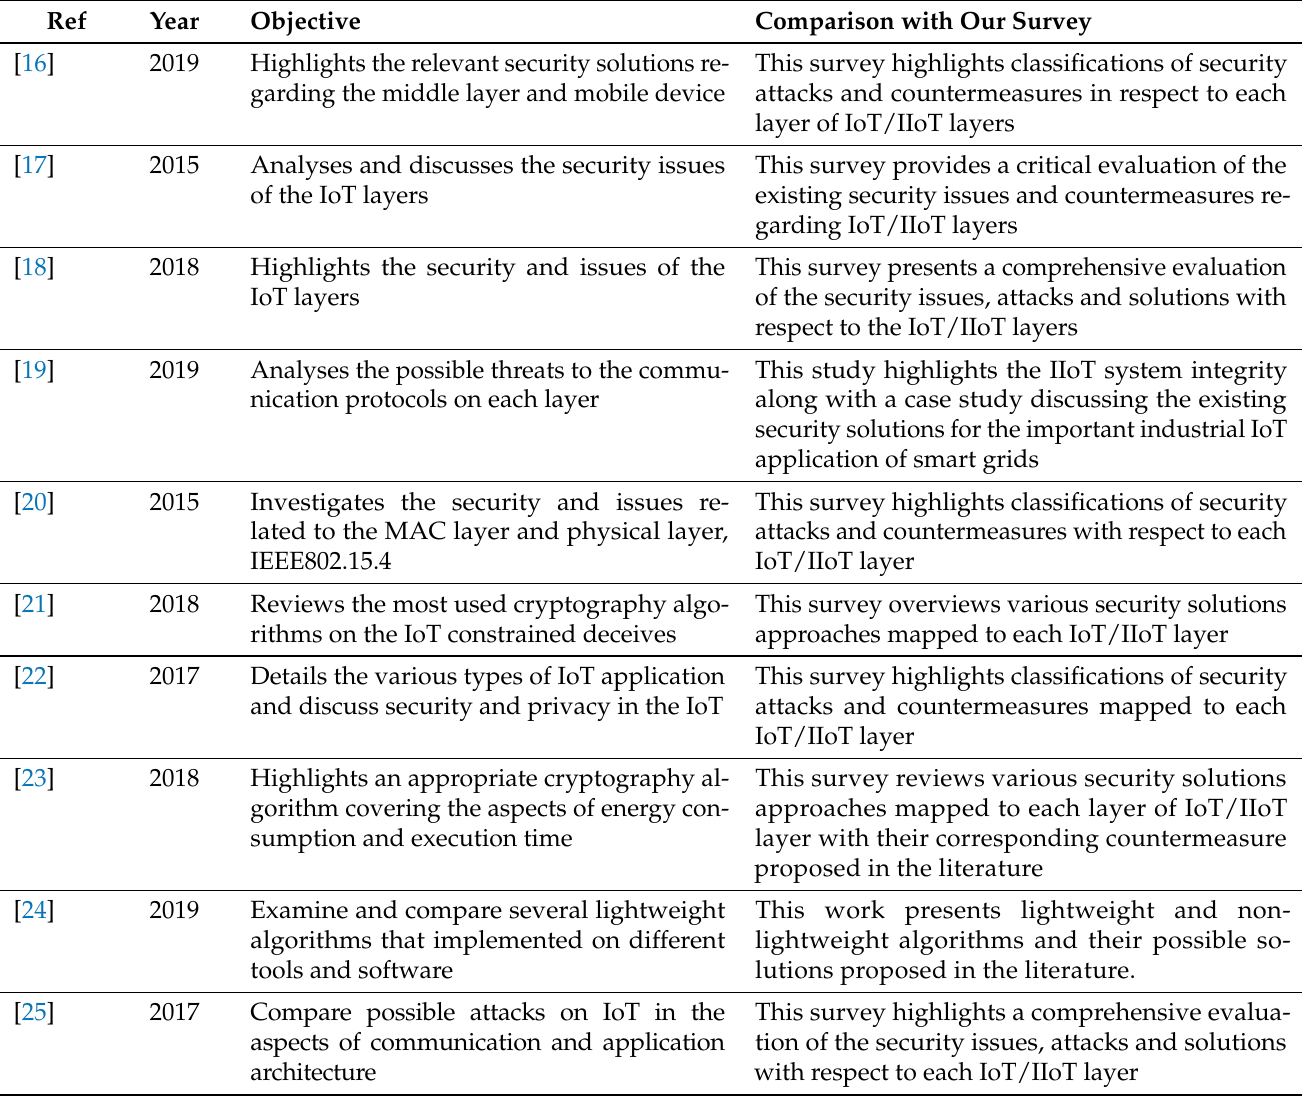
Table 1. Comparison of relevant